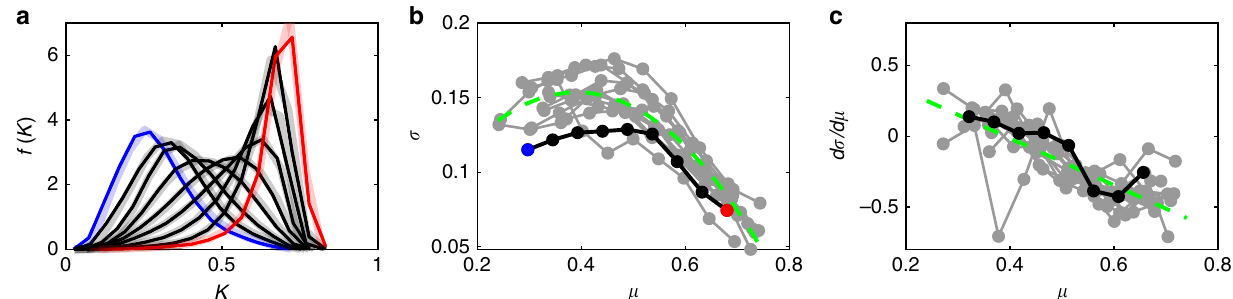
Fig. 3 Statistics of the clearness index. a Probability density functions (pdf) of daily clearness index ( K ) in different regions over the world (binning width of 0.05) from the satellite data in January during 2001 – 2009 (dark color) and during 2010 – 2018 (light color). b Relationship between mean ( μ ) and standard deviation ( σ ) of daily K . The black/blue/red dots correspond to the lines in the a ; the grey dots are from 11 climate model outputs during 2006 – 2015; the dash green curve shows the best quadratic fi t. c d σ / d μ calculated as the derivative of the corresponding σ ~ μ relationship in ( b ). Source data are provided as a Source Data fi le.